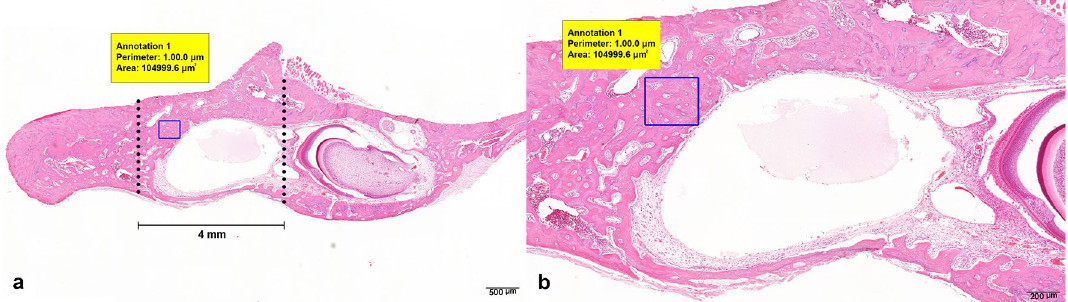
Figure 3. Osteocyte and Haversian canal count method, 2 × ( a ). At the center of the defect area with bone regeneration, a 500 × 500 μm fixed rectangle was selected as the area of interest for counting, 5 × ( b